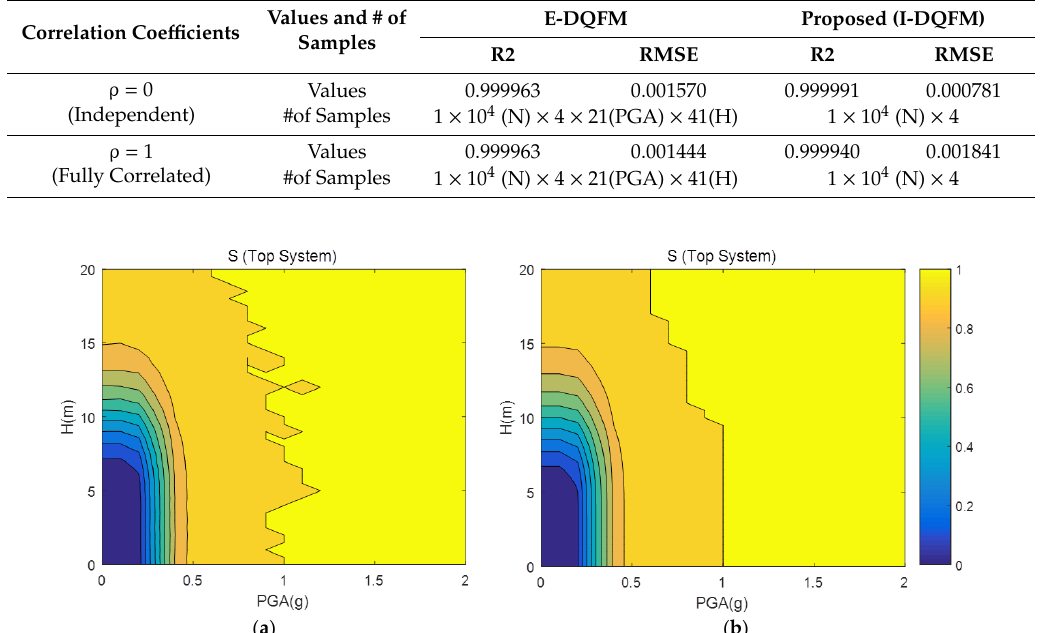
Figure 10. Comparison of multi-hazard system fragility results regarding the example (C1 ∪ C2) ∩ C3 ((3) partially dependent condition): ( a ) E-DQFM; ( b ) proposed (I-DQFM).